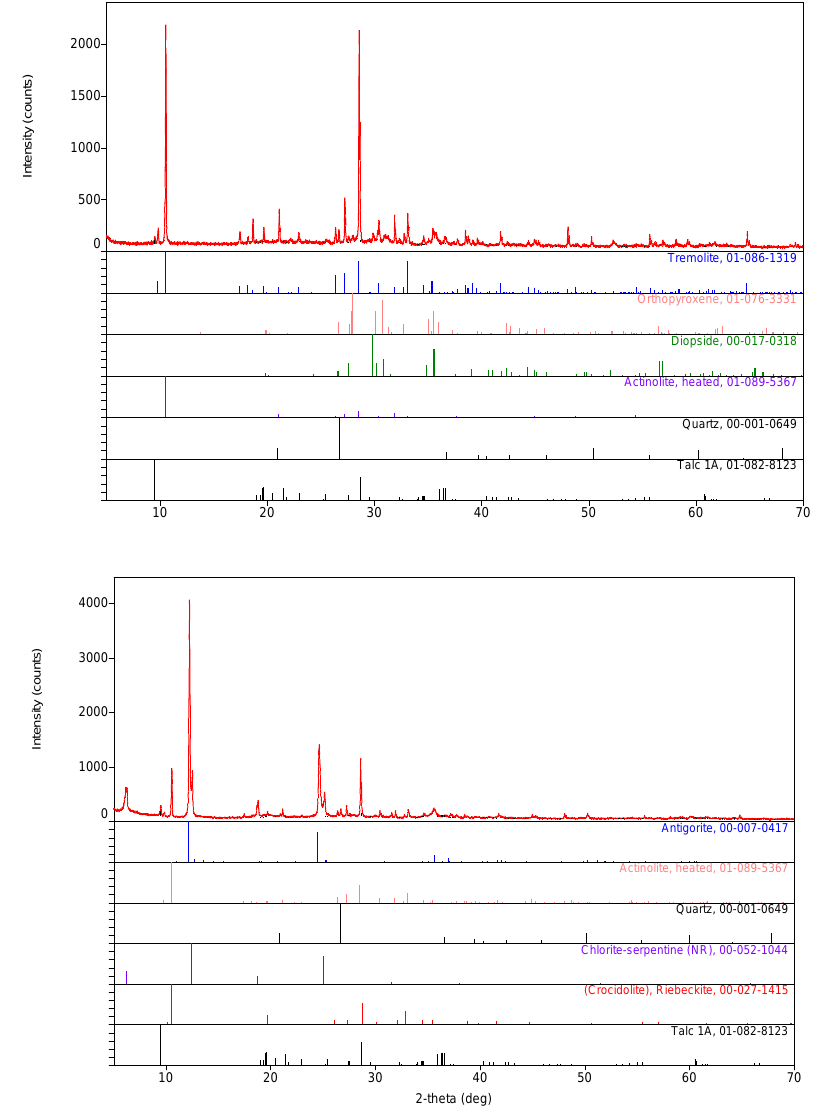
Figure 5. XRPD patterns for samples c ( top ) and d ( bottom ). XRPD patterns of indexed phases: antigorite (PDF# 00–007-0417), heated actinolite (PDF# 01-089-5367), quartz (PDF# 00-001-0649), chlorite–serpentine (NR) (PDF# 00-052-1044), crocidolite (riebeckite) (PDF# 00-027-1415), tremolite (PDF# 01-086-1319), orthopyroxene (PDF# 01-076-3331), diopside (PDF# 00-017-0318) and talc 1A (PDF# 01-082-8123) are presented in the form of straight intensity lines at the pattern bottom [21–29]. See Appendix A for XRPD patterns of samples a and b.